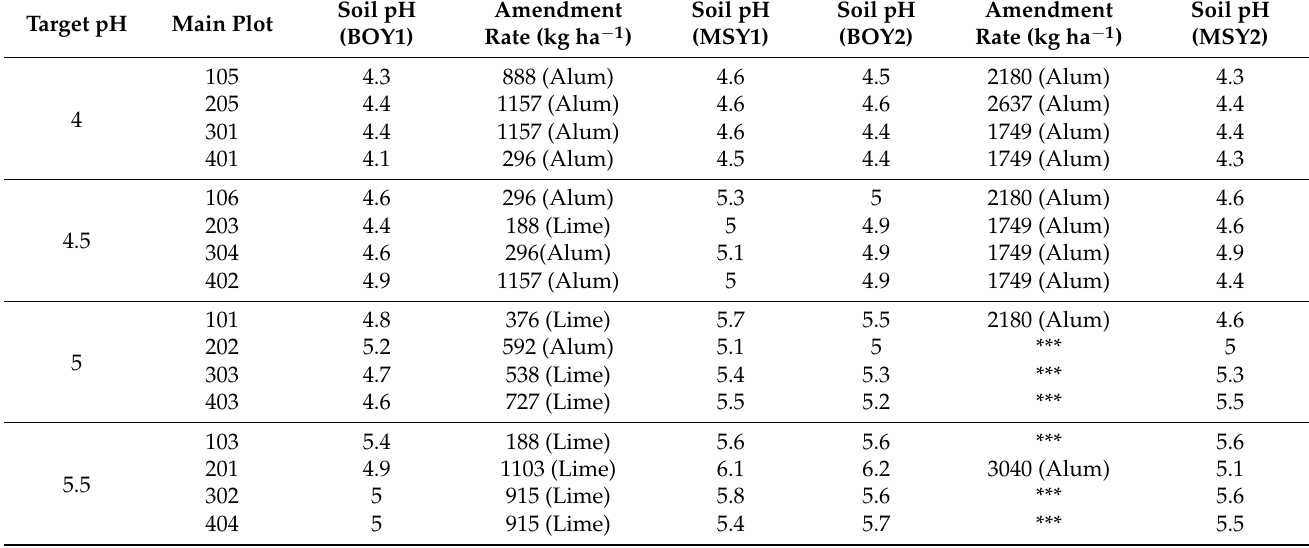
Table 3. Continuous monitoring for 2 winter wheat cropping seasons regarding soil pH, target soil pH, and aluminum sulfate (Alum) and calcium hydroxide (Lime) amendment rates for each main plot at Stillwater. Soil pH Target pH Main Plot